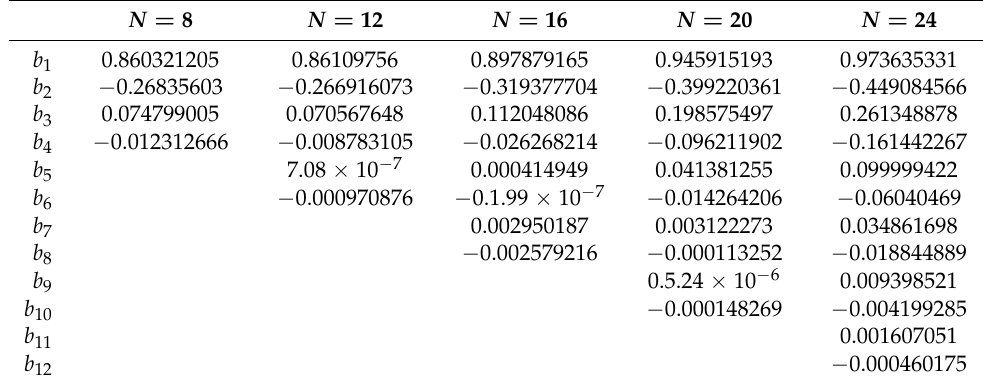
Table 3. The finite-difference coefficients for the first derivative optimized by